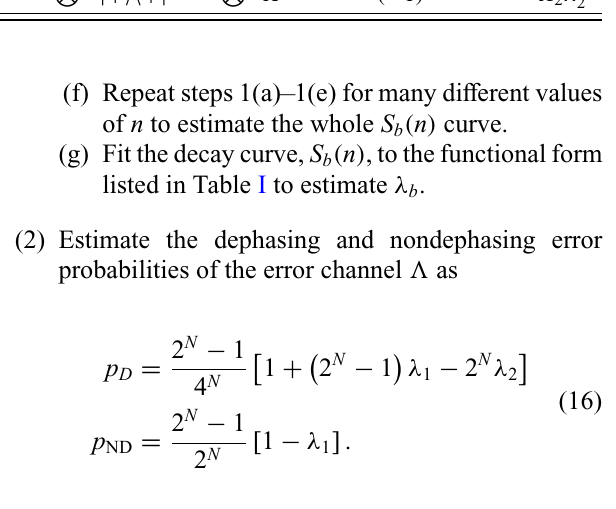
Table I. Weight the outcome by χ ∗